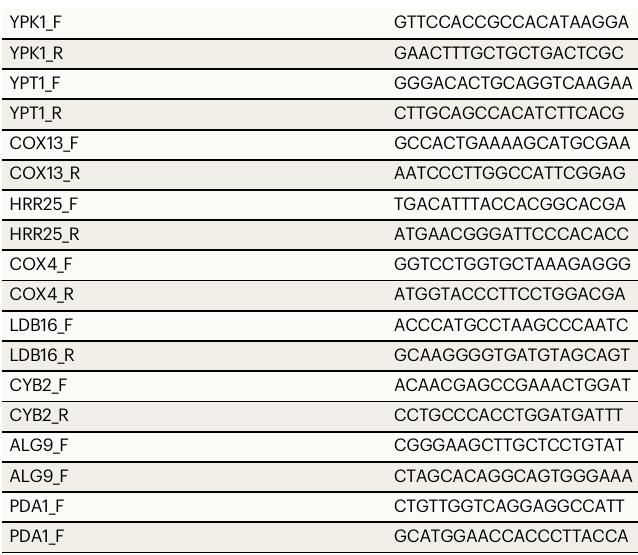
Table 2 | Primers ’ sequence used for RT-qPCR, at a fi nal concentration of 5 μ